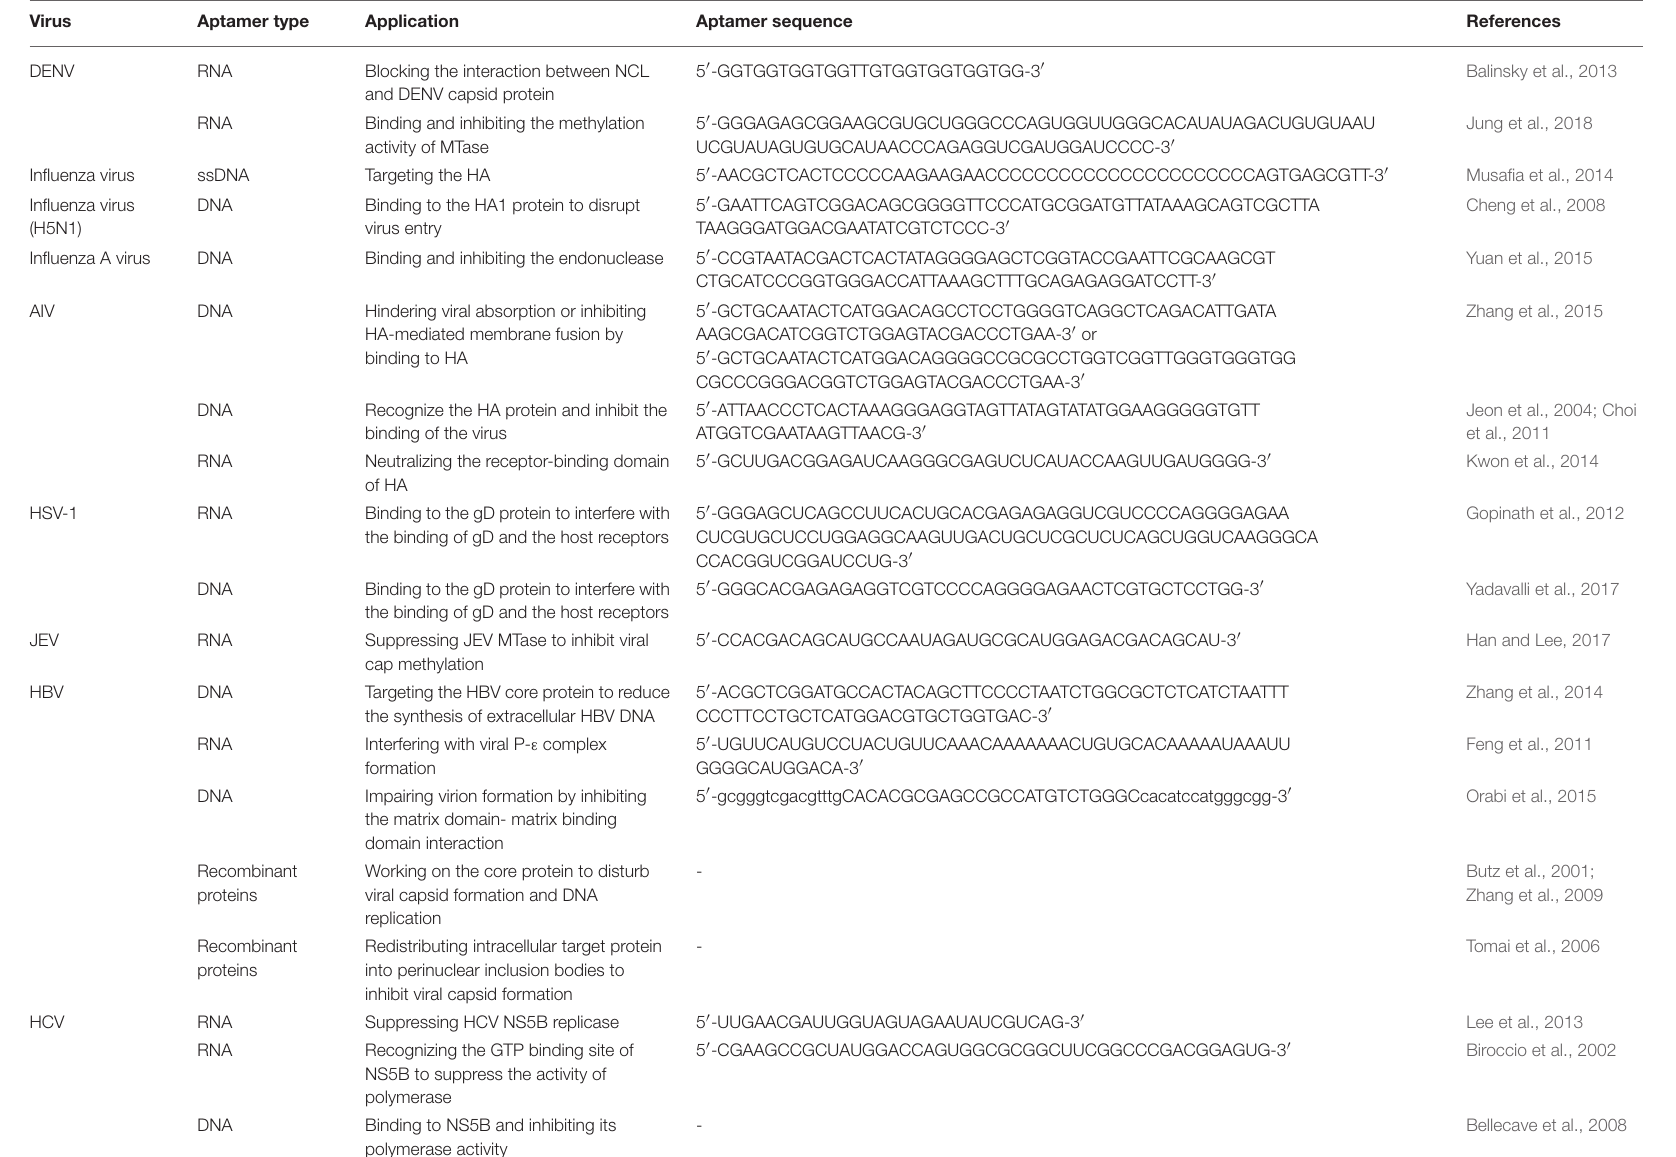
TABLE 3 | Summary of aptamers and aptamer-based experiments in antiviral